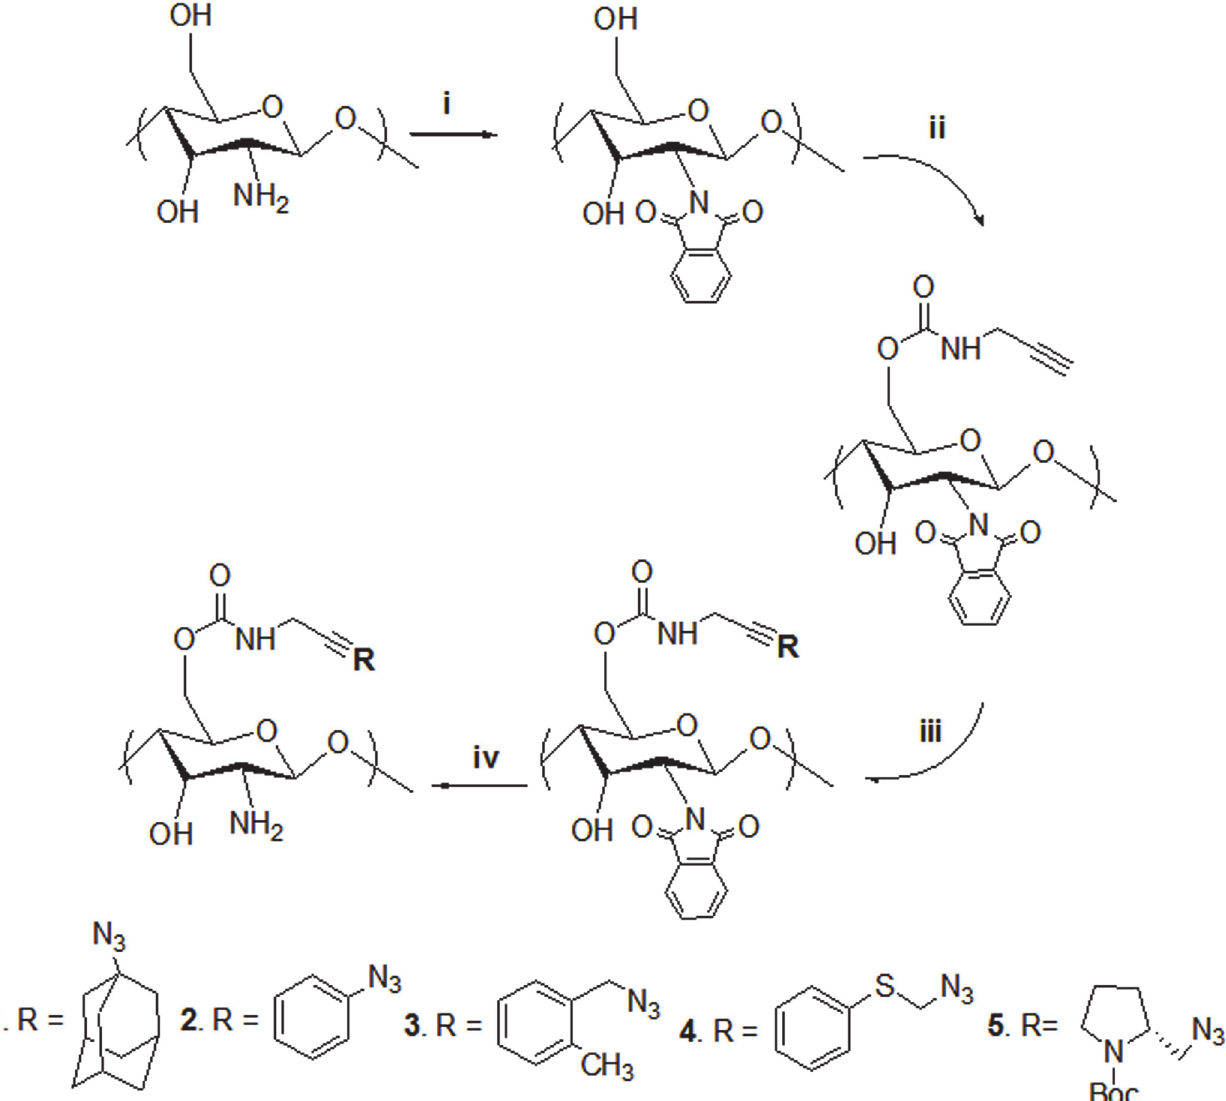
Fig 1. Synthetic scheme of chitosan derivatives. Synthetic scheme of chitosan azide functional derivatives.(i) phthalic anhydride, DMF 5%(v/v), 8h, N 2 atmosphere,120°C, (ii) THF,CDI, 5h, N 2 atmosphere, 40°C, propargylamine, THF,24h, 25°C, (iii) sodium ascorbate, copper (II) acetate, (1-azidoadamantane / azidobenzene/ 1-azidomethyl-2-methyl benzene / azidomethyl phenyl sulphide / 2-azidomethyl-1-boc pyrolidine), tertbutanol/ water, 24h, 25°C, (iv) NH 2 NH 2 .H 2 O,water, 18h,